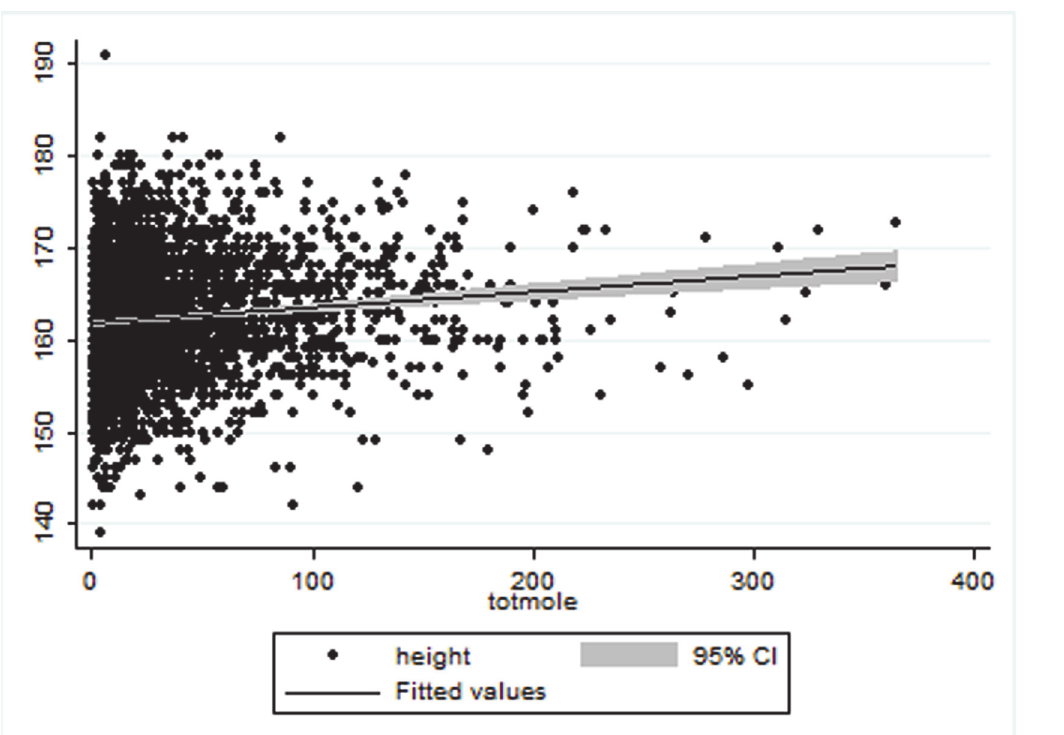
Figure 1. Scatter plot for height (Y axis) in association with naevus count (X axis).